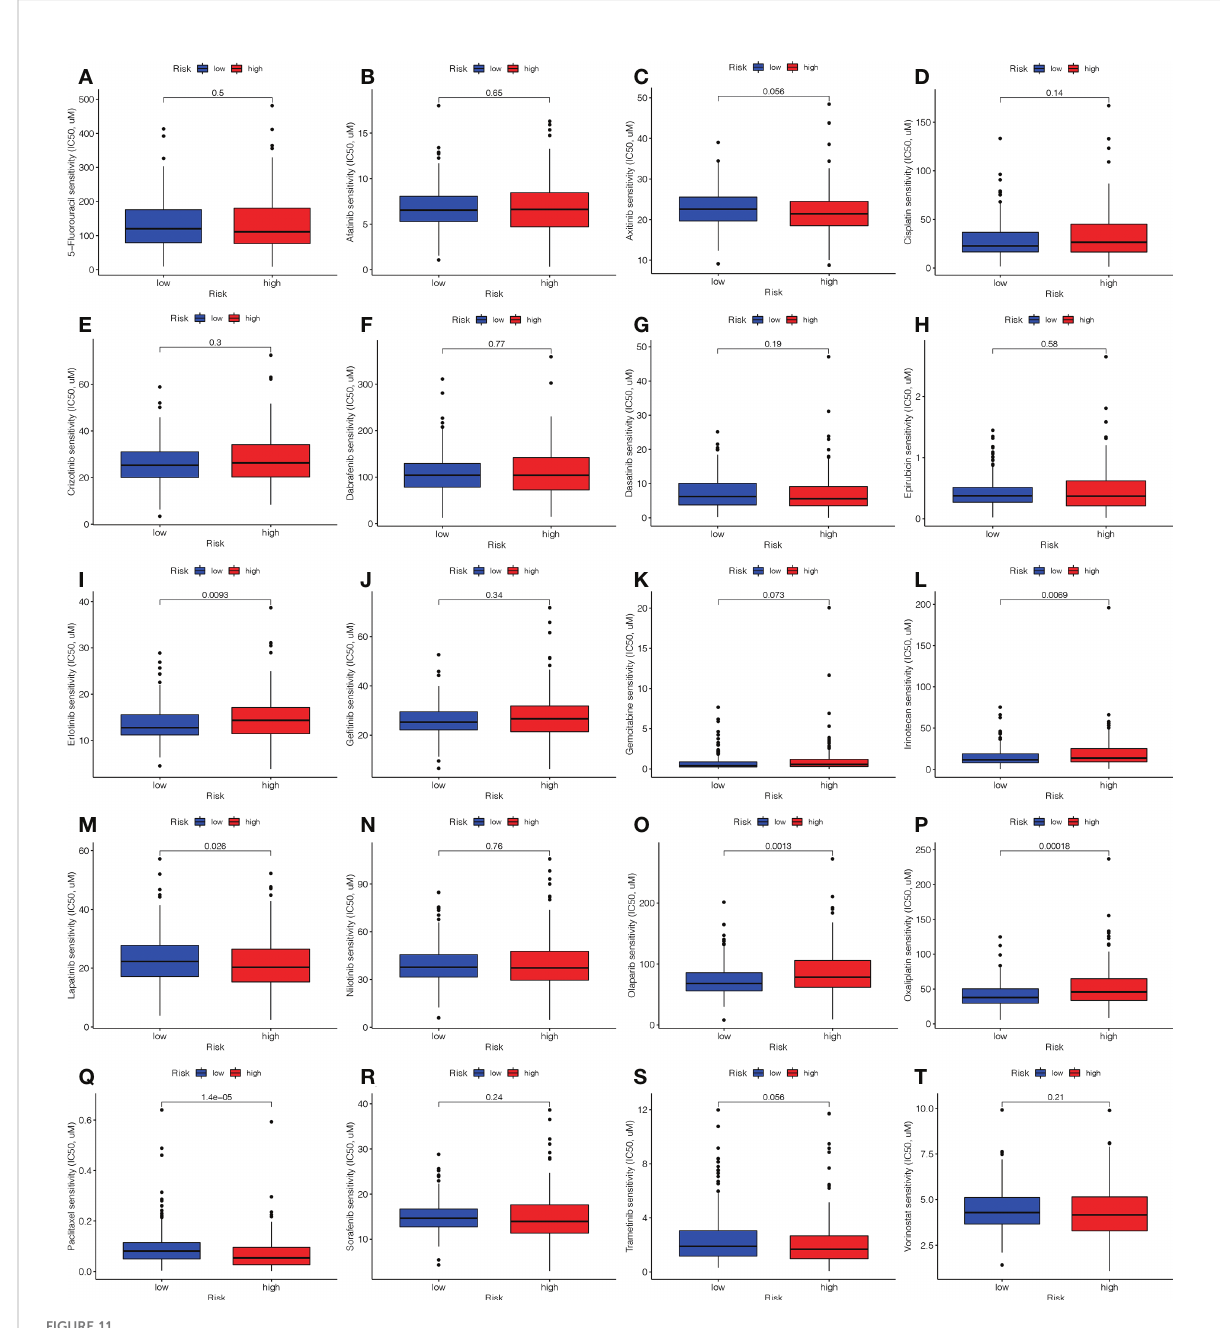
FIGURE 11 Comparison of the treatment medication sensitivity of individuals at high (H)- and low (L)-risk. IC50s of (A) 5- fl uorouracil, of (B) afatinib, of (C) axitinib, of (D) cisplatin, of (E) crizotinib, of (F) dabrafenib, of (G) dasatinib, of (H) epirubicin, of (I) erlotinib, of (J) ge fi tinib, of (K) gemcitabine, of (L) irinotecan, of (M) lapatinib, of (N) nilotinib, of (O) olaparib, of (P) oxaliplatin, of (Q) paclitaxel, of (R) sorafenib, of (S) trametinib, of (T) vorinostat in H and L risk